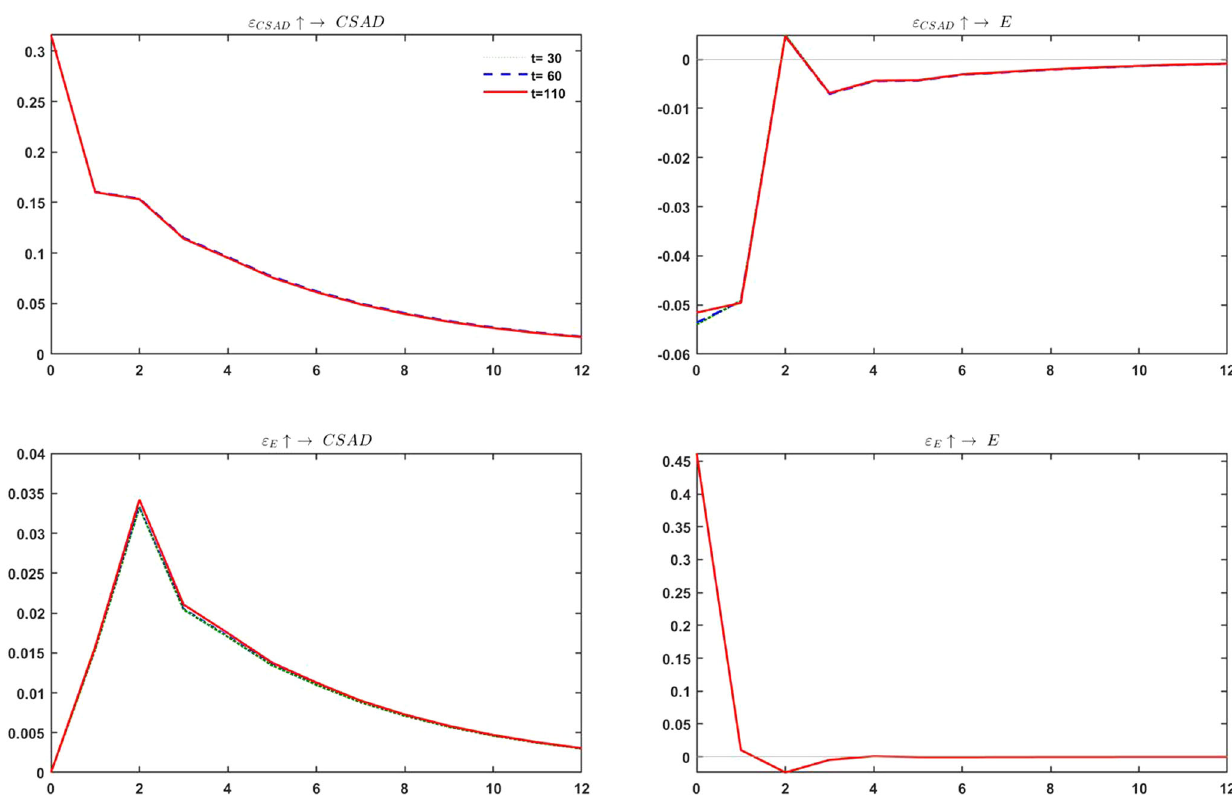
Fig. 3 Impulse responses at different time points. The responses of market dispersion and internet postings to a unit shock in a unit shock at different time